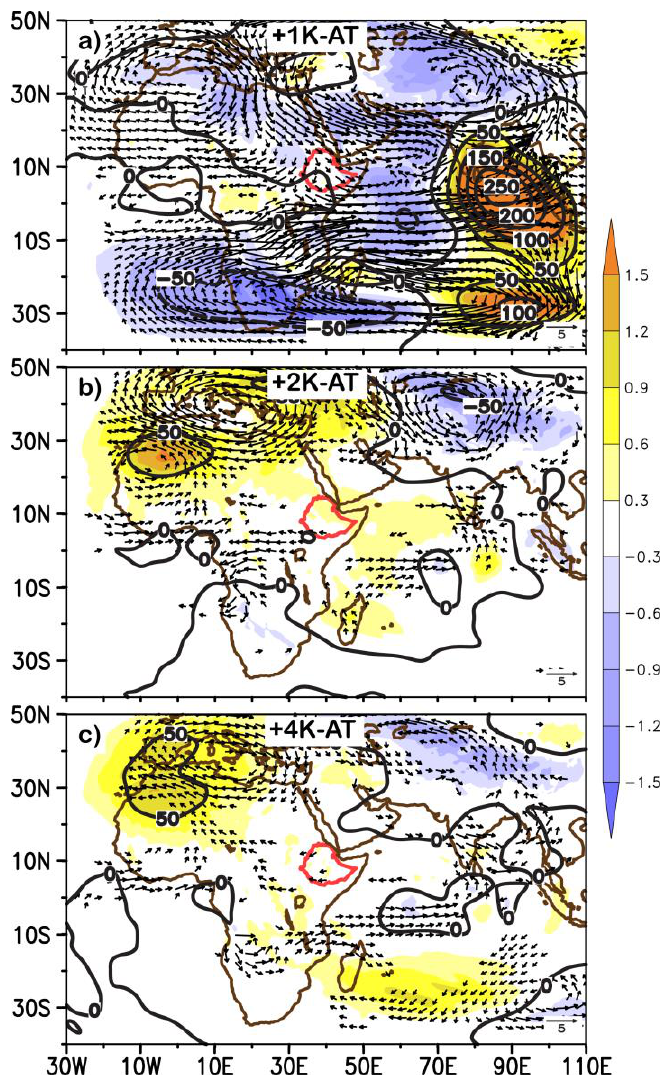
Figure 11. Circulation changes from CNTRL at 150 hPa averaged over July-August for SST anomaly (SSTA) forcing of ( a ) +1K, ( b ) +2K, and ( c ) +4K over the Atlantic Ocean (AT; 40°S–35°N, 30°W–15°E). Each panel shows differences in horizontal winds (vectors; m·s −1 , magnitude scale in lower right corner), temperature (shading; K, color scale at right), and geopotential height (contours; gpm) between the perturbed SSTA forcing experiments and CNTRL. Differences of geopotential heights are contoured every 50 gpm. Anomaly vectors are plotted for resultant magnitudes of at least 1 m·s −1 only. The border of Ethiopia is delineated in solid red line. See Table 1 for description of experiments. See Table 1 for description of